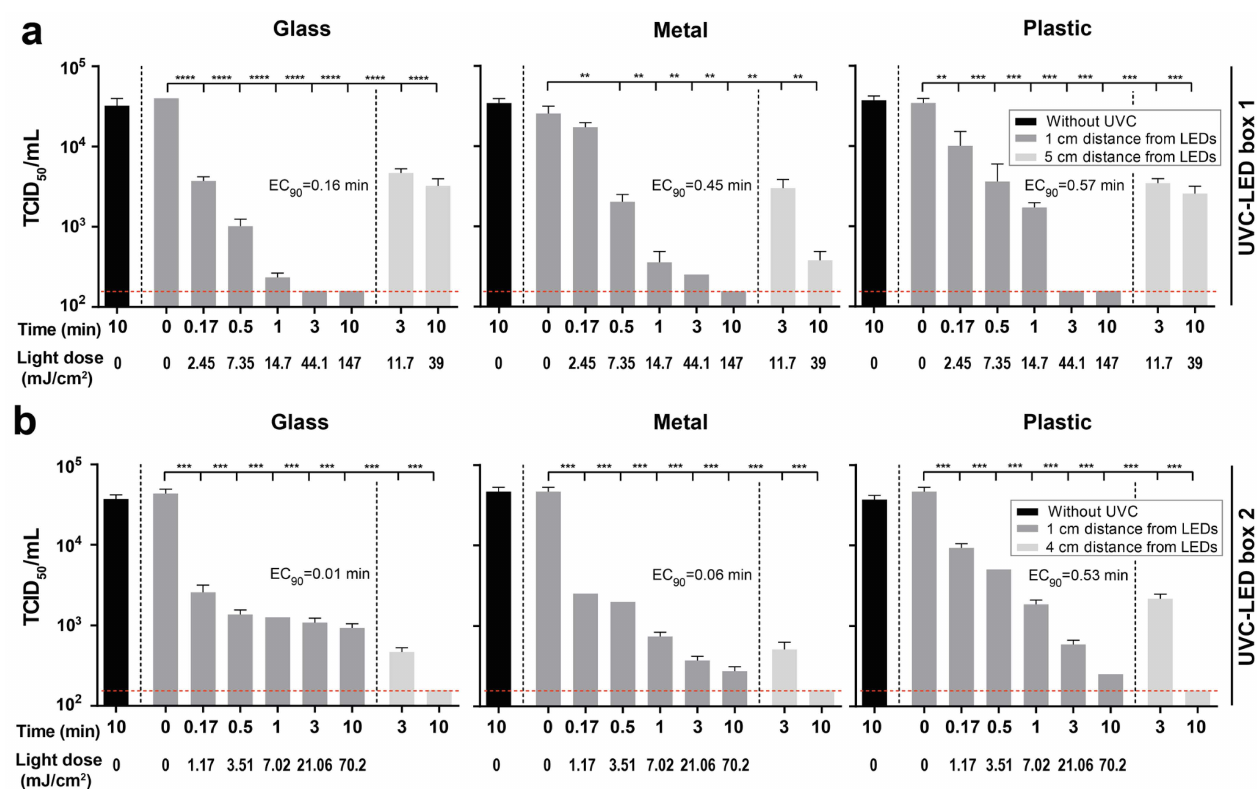
Figure 3. Disinfection of severe acute respiratory syndrome coronavirus 2 (SARS-CoV-2)-contaminated objects by two distinct UVC-LED boxes. Glass, metal, and plastic samples were contaminated with SARS-CoV-2 at a final concentration of 4.5 × 10 6 TCID 50 /mL for UVC-LED box 1 and 1.8 × 10 6 TCID 50 /mL for UVC-LED box 2 in a cell culture medium mixed with defined organic matrix, thereby mimicking the viral contamination on the surfaces of personal belongings such as smartphones, keys, coins, or credit cards. The samples were exposed to LED-UVC light for 0 s, 10 s, 30 s, 1 min, 3 min, and 10 min at different distances from UVC-LEDs inside the UVC-LED boxes. Experiments were conducted in triplicates. ( a ) In UVC-LED box 1, samples were irradiated at a distance of 1 and 5 cm from the UVC-LEDs. ( b ) In UVC-LED box 2, samples were irradiated at 1 and 4 cm from the UVC-LEDs. Light doses at 4 cm distance cannot be shown, as an irradiance measurement of the LEDs at that distance would have required drilling a hole into the bottom of the box, which was not possible without damaging the box. The limit of detection of the assay was at 159 TCID 50 /mL (indicated by the red dotted line). Data are displayed as mean ± SD. ** p < 0.01; *** p < 0.001; and **** p < 0.0001. TCID 50 = tissue culture infectious dose, 50%; EC 90 = 90% effective